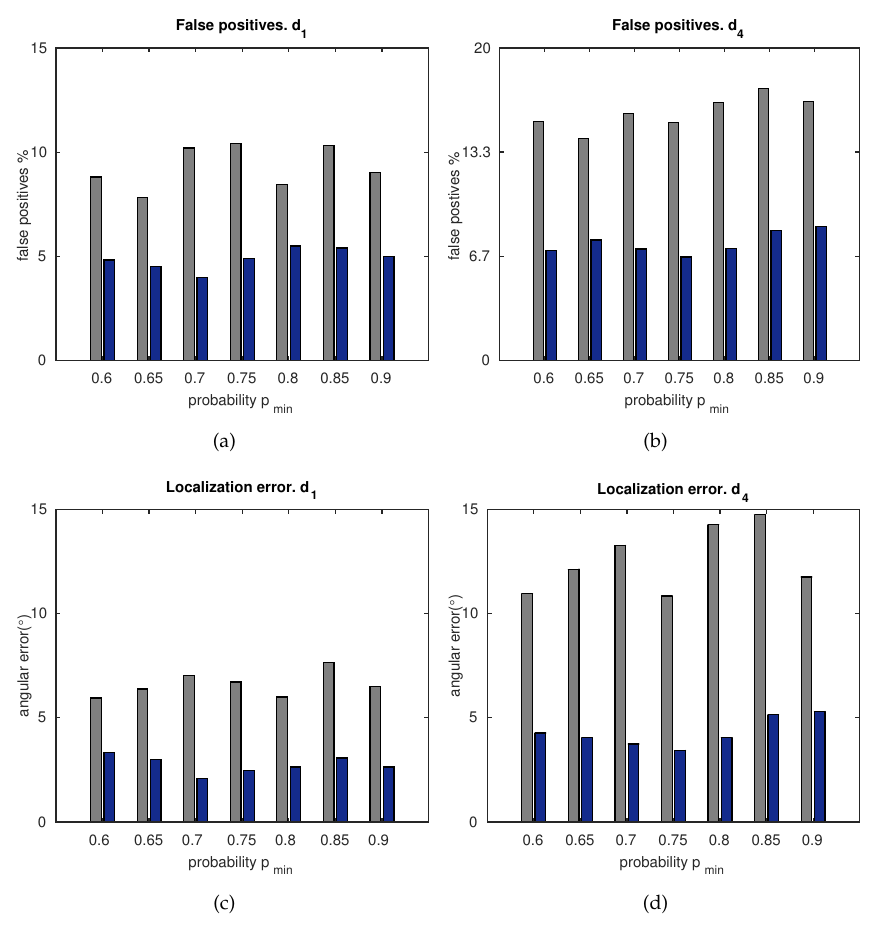
Figure 12. Top row: percentage of false positives. ( a ) Distance d 1 ; ( b ) distance d 4 . Bottom row: localization error (in β and φ ) versus p min . ( c ) Distance d 1 ; ( d ) distance d 4 . Legend: (cid:4) standard matching; (cid:4) proposed